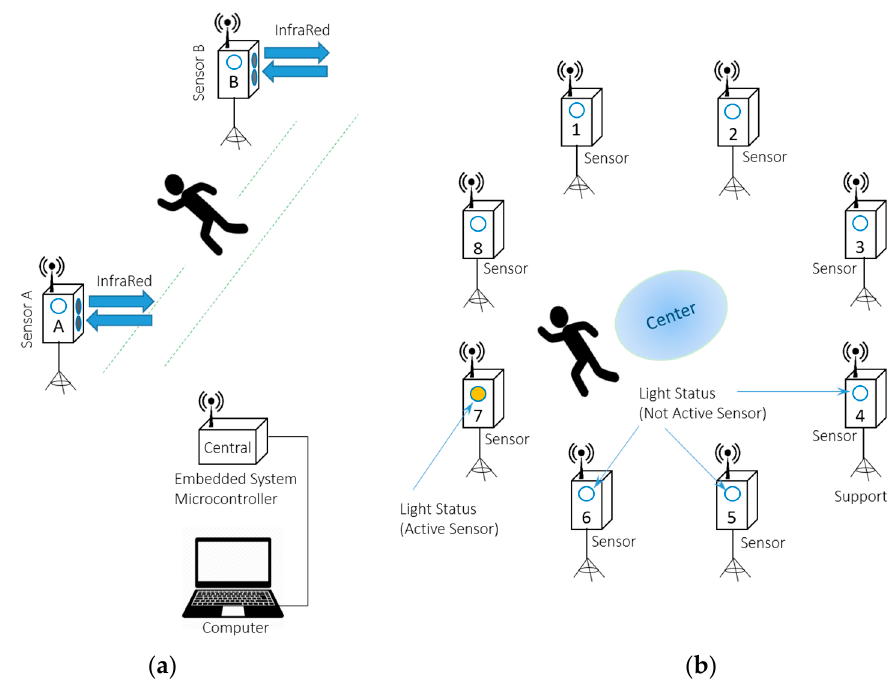
Figure 5. A system for collecting collection time in continuous running ( a ) and agility tests ( b ).